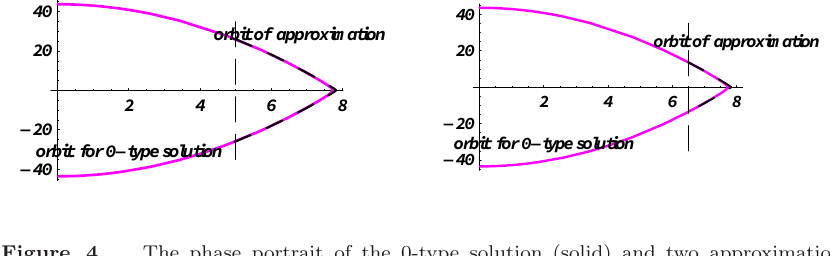
The phase portrait of the 0 -type solution (solid) and two approximations (dashed).